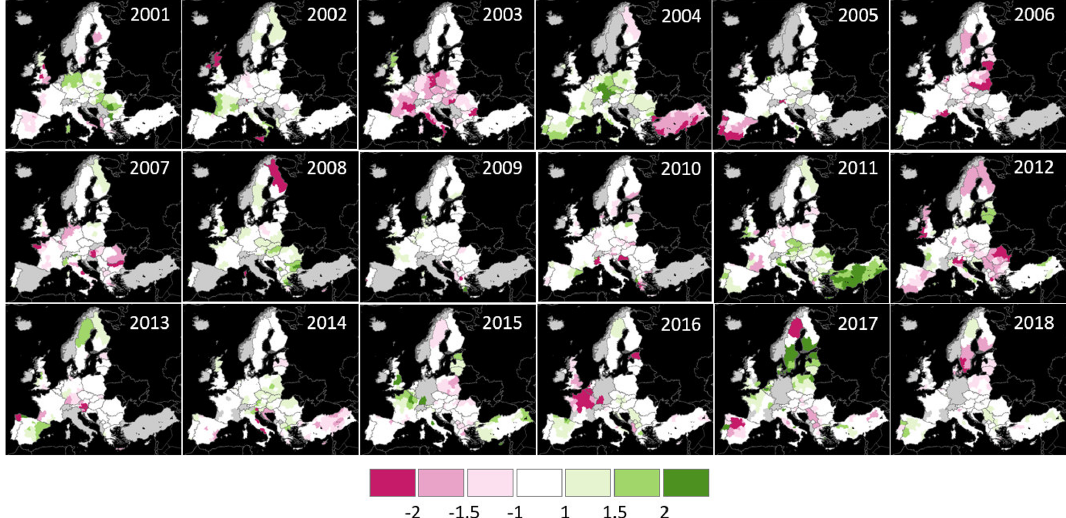
Figure 2. Spatial distribution of annual standardised yield anomalies for the period 2001–2018. Anomalies are mapped at NUTS 2 level, with the exception of the areas detailed in Sect. 2.1. Data in grey are